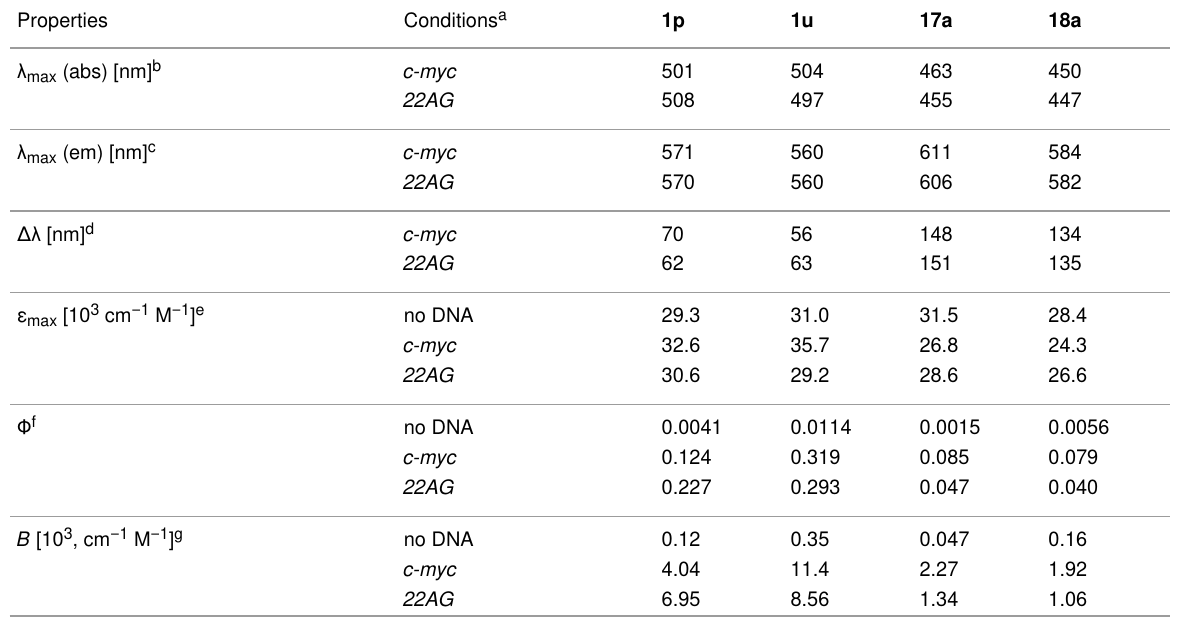
All dyes display moderate to good quantum yields and bright- nesses upon complexation with both G4 analytes. In more detail, distyryl dyes 1p and 1u prove more performant in this sense, displaying higher quantum yield and brightness ( Φ